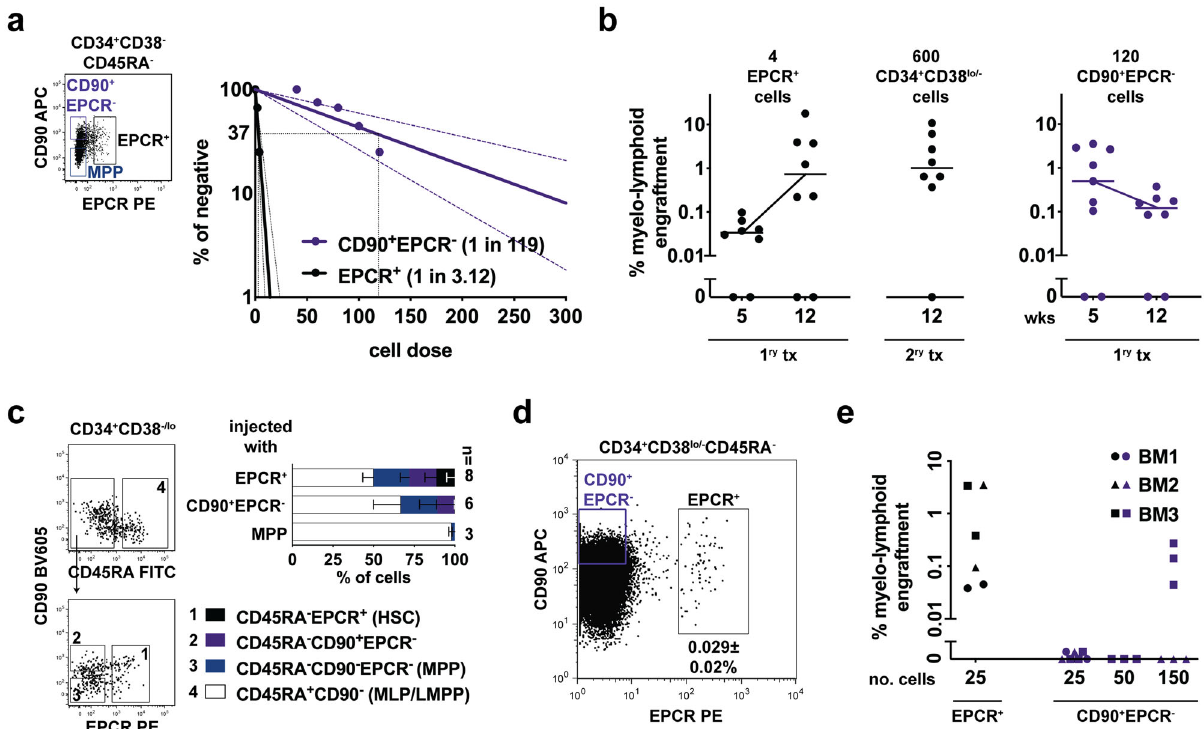
Fig. 4 Most self-renewing EPCR + cells are at the top of a newly de fi ned human CD34 + HSPC hierarchy. a Representative FCM plot illustrating the gating strategy used to sort CB EPCR + , CD90 + EPCR - and MPP populations and SRC frequency of EPCR + and CD90 + EPCR - populations; 95% con fi dence interval is shown. b Engraftment kinetics of the indicated cell populations. Mice were transplanted with ~1 SRC dose for 1 ry tx and 2 ry tx respectively. Results were from three independent experiments ( n = 8 – 9 mice); median lines are shown. c Representative FCM plots illustrating the phenotype of the denoted sub-populations within CD34 + CD38 lo/ − HSPCs detected at 12 wks in a primary mouse bone marrow transplanted with EPCR + cells. Cumulative data from all the mice that yielded suf fi cient HSPCs is shown ( n = 3 – 8 mice). The percentages were calculated based on the gates shown (for BMs engrafted with CD90 + EPCR − cells and MPPs see Supplementary Fig. 3b). d Representative FCM plot showing the presence of EPCR + and CD90 + EPCR − cells in adult